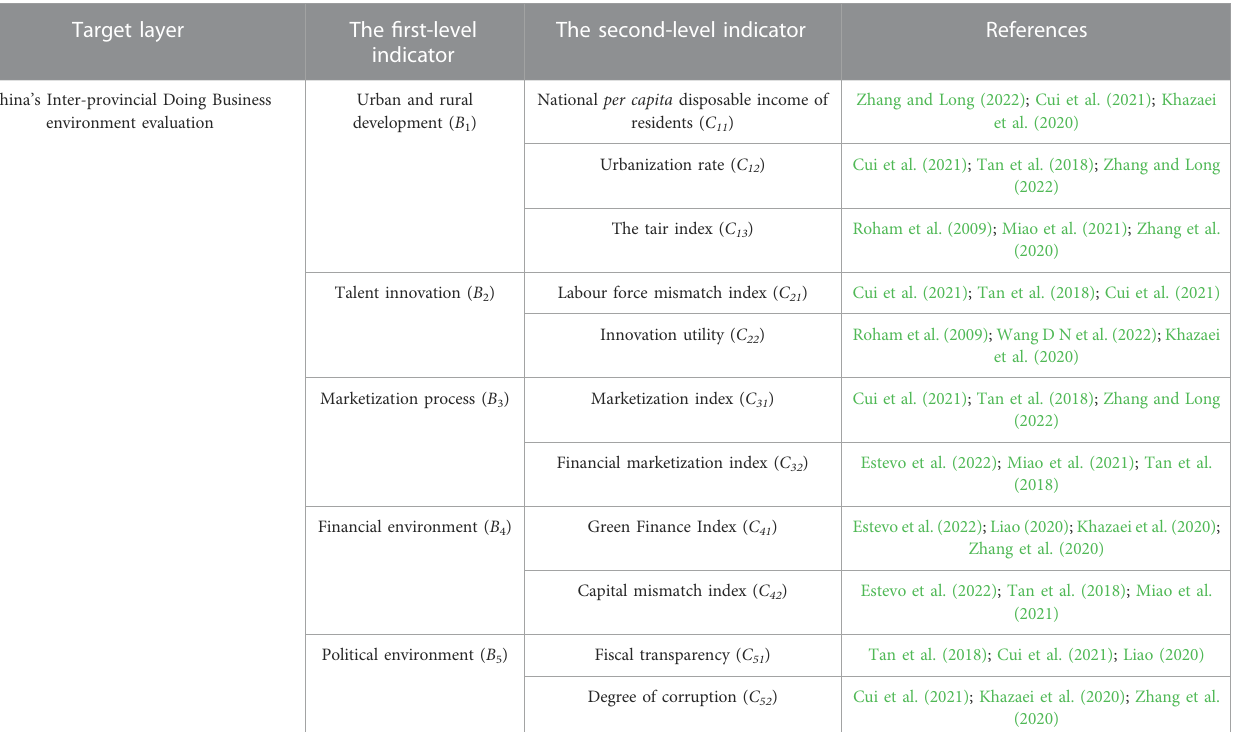
TABLE 1 China ’ s inter-provincial DB environment evaluation index